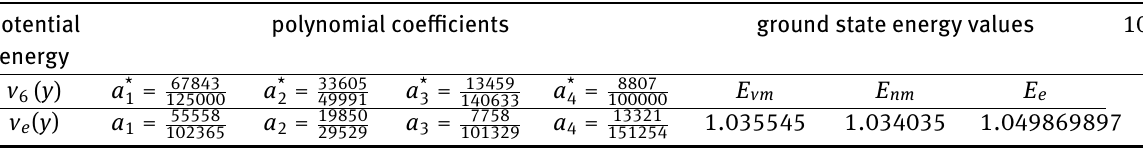
polynomial coeflcients